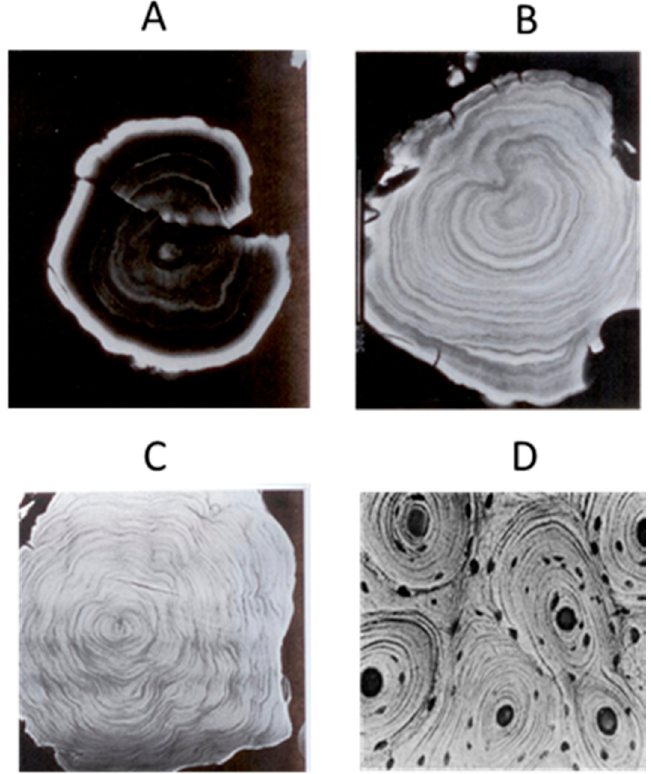
Figure 3. The laminated pineal gland calcification at different ages and their similarity to the osteons of compact bone. ( A ) Pineal calcification in 14 year old subject; ( B ) 47 year old; ( C ) 62 year old; ( D ) osteons; ( A – C ) were modified from Hermann et al. [239].